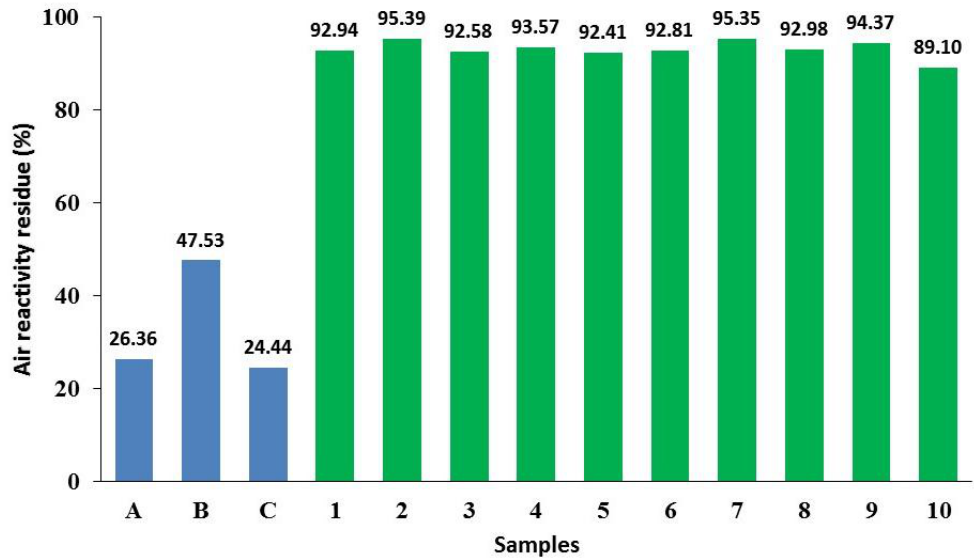
Figure 2. Air reactivity of the samples coated by impregnation.